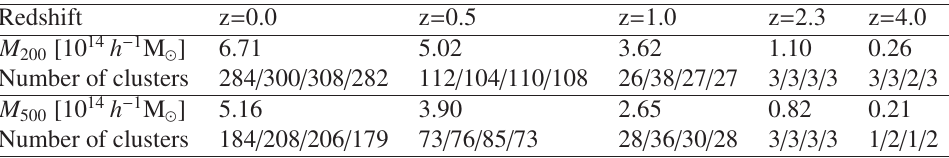
Figure 3. The di ff erential HMF di ff erences with respected to the one from MDPL2 above the mass completeness. The same mass bin with size of 0.05 in logarithm space is applied. Left panel shows the results of M 200 with M 500 is presented on the right panel. In each panel, only the results from z = 0 . 5 (dotted lines), and 0.0 (solid lines) are presented due to the statistic limits. The median changes for all bins with 8 clusters are shown in ≥ the top left corner of each